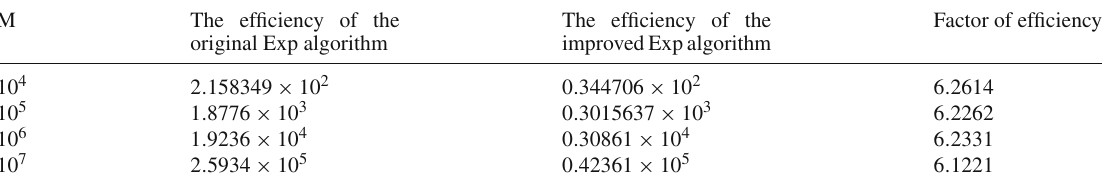
Table 1 The efficiency of simulation algorithms as (simulated variance × CPU time) for the down-and-out call barrier option under CEV model with β = − 0 . 5, σ = 0 . 25 and (cid:7) = E [ δ t ] = 0 . 002 M The efficiency of the The efficiency of the Factor of efficiency original Exp algorithm improvedExp algorithm